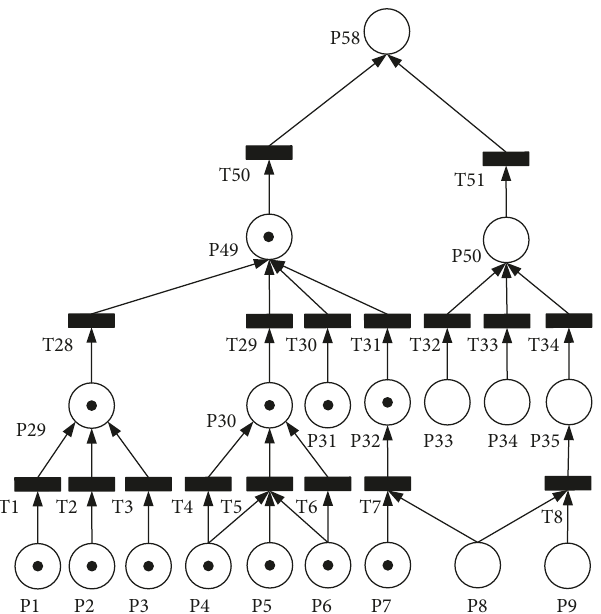
Figure 6: Token distribution after backward reasoning.